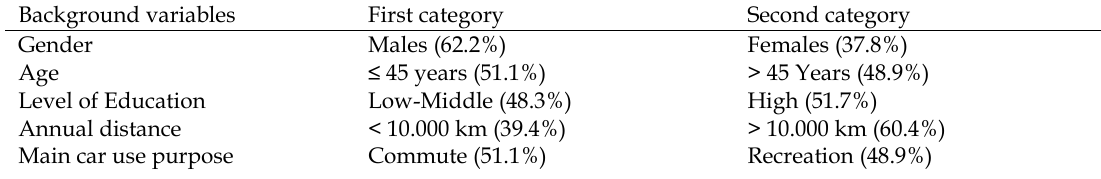
Table 1. Sample distributions of background variables